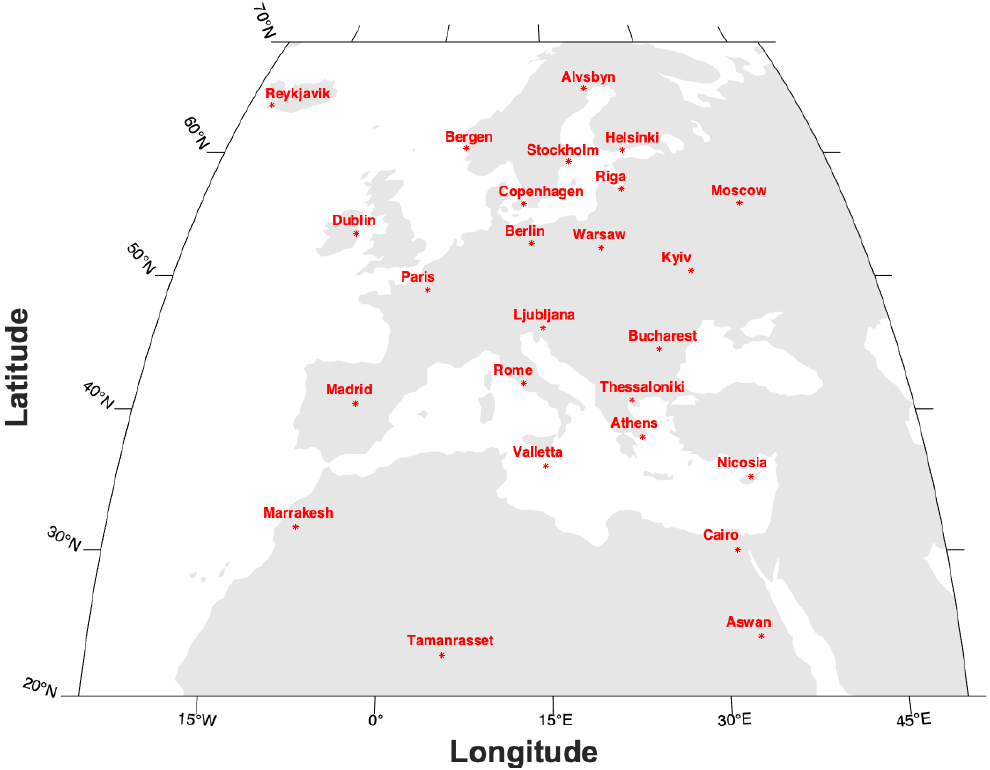
Figure 1. Locations of the Cities in Europe and North Africa selected for the study.